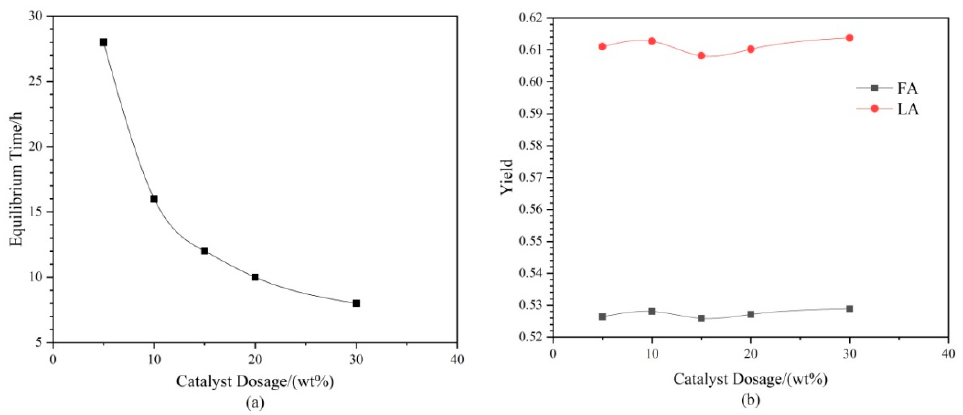
Figure 7. Effect of catalyst dosage on the yields of ( a ) LA and ( b ) FA.